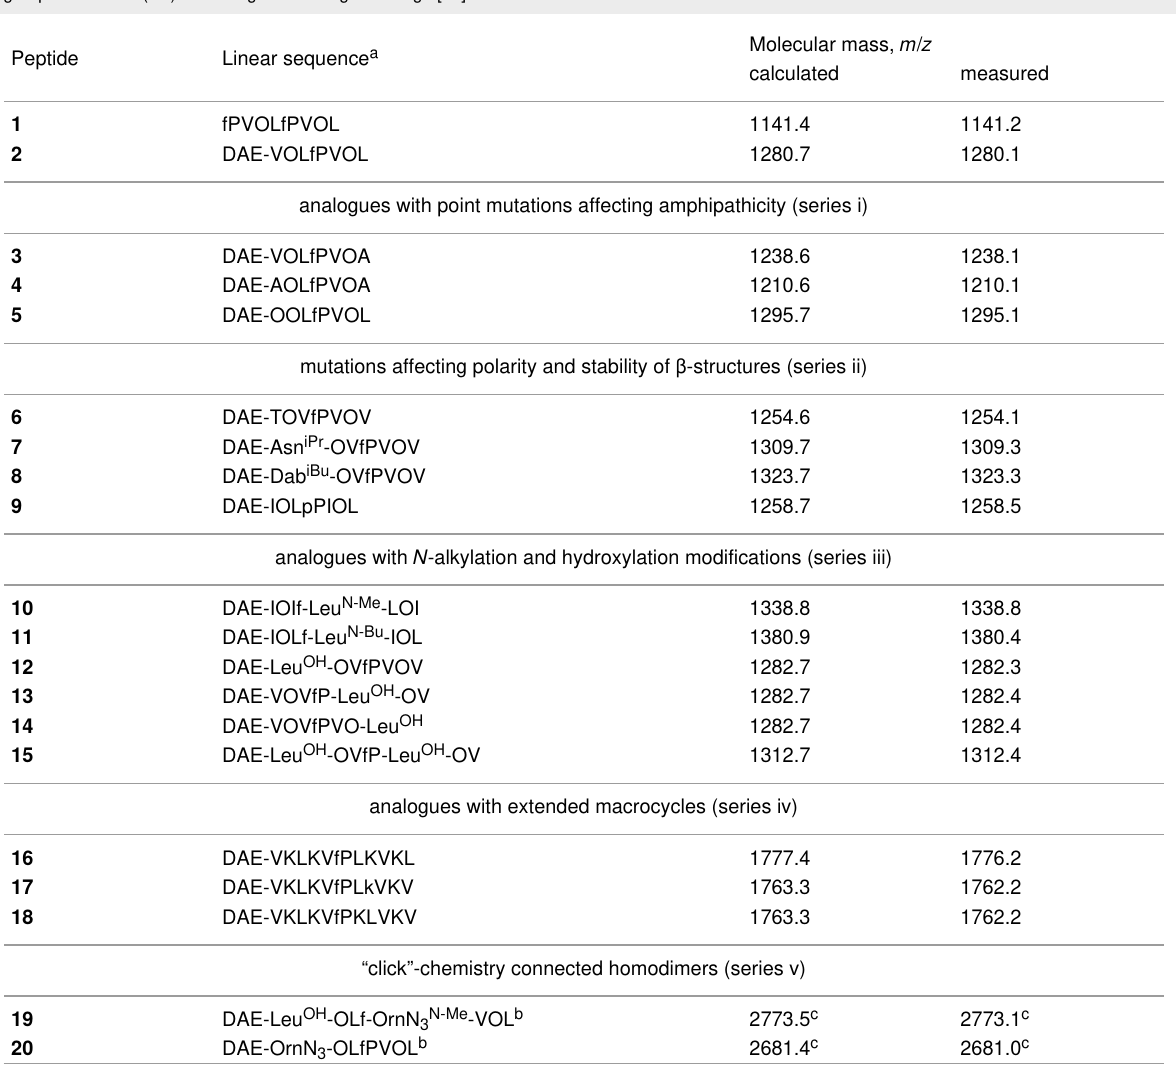
Table 1: Nomenclature, sequences, molecular masses of the peptides synthesized and explored in this study. The photoswitchable peptides are grouped in series (i–v) according to their original design [30].